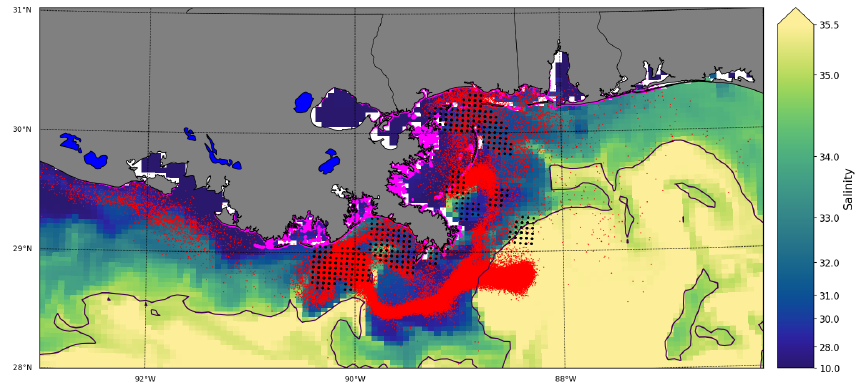
Figure 12. End condition of the Reference simulation 2–10 July 2010 (same simulation as in Figure 11b), showing active elements at surface as red dots and the corresponding observed surface oil patch (NOAA shape file) as black dots. Stranded oil is shown in magenta. The color scale shows sea surface salinity in the forcing data. The black contour is the 35 PSU